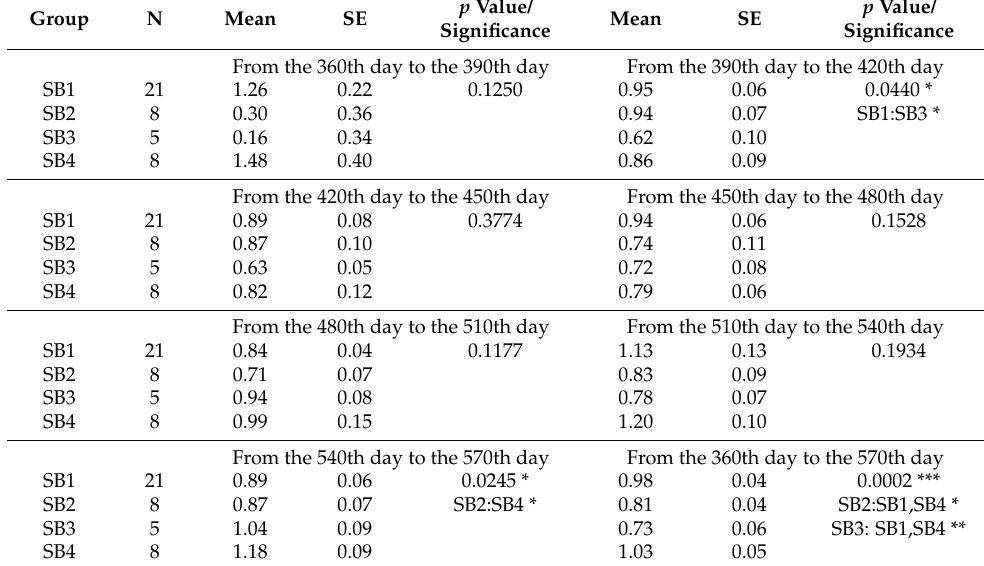
Table 2. Effects of birth season on the average daily gains in heifers (kg).